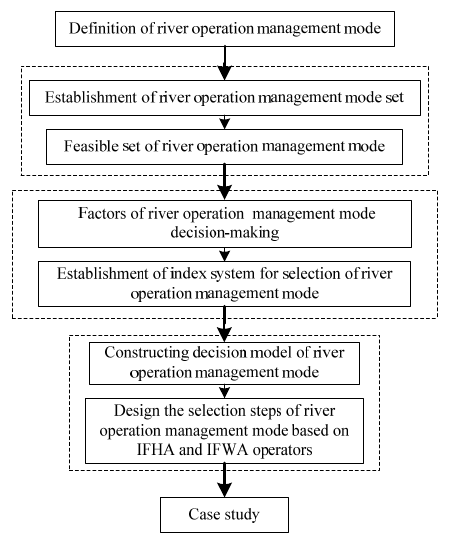
Figure 1. Technical roadmap of this research.